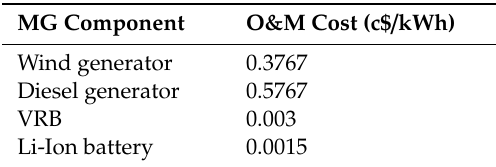
Table 3. Operation and maintenance (O&M) cost parameters for various microgrid components. VRB: vanadium redox battery and MG: microgrid.